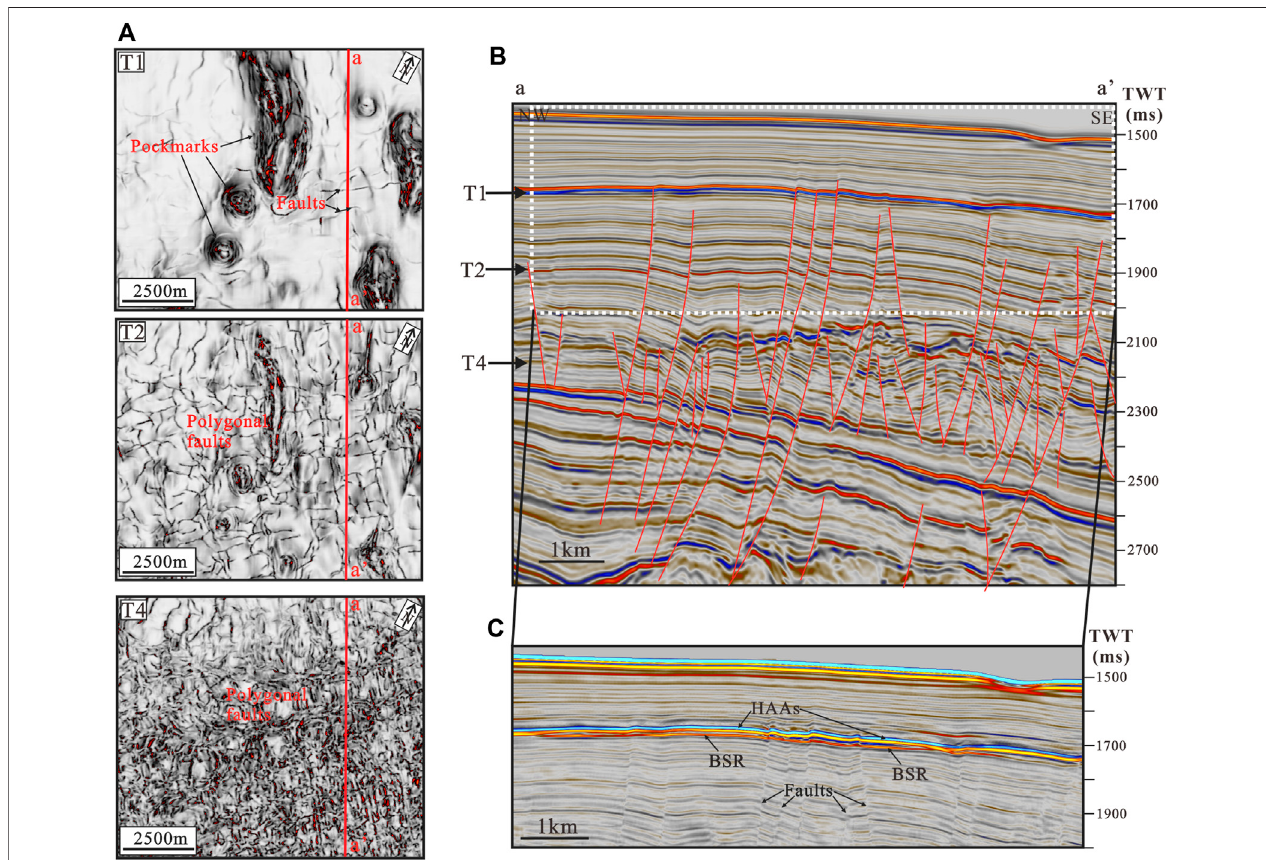
FIGURE 6 | Three-dimensionality of polygonal fault geometry. (A) Three coherence slices extracted from horizons T1, T2, and T4, respectively, show polygonal faults ’ variations at different depths. (B) Seismic pro fi le showing the position of three coherence slices showing complex tier, with few master faults transecting the full thickness reaching the BSR and HAA and with many other smaller faults (C) . The reprocessed seismic pro fi le showing the relationship between BSR, HAAs, and faults.